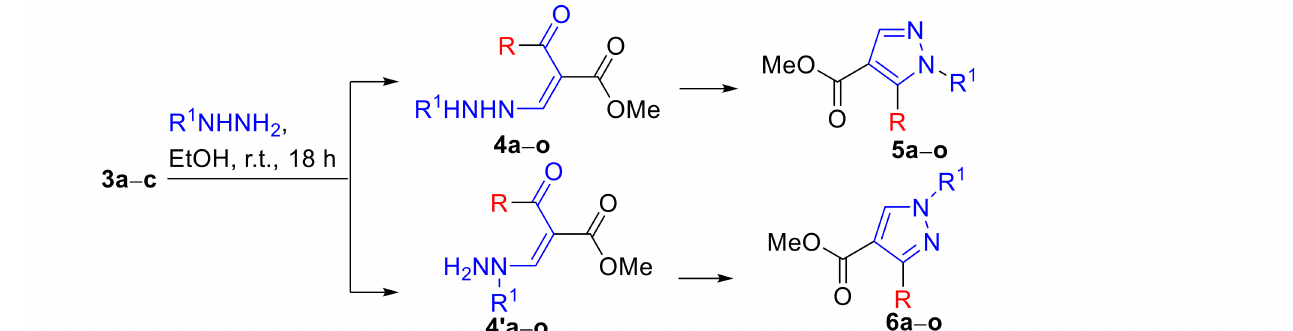
Scheme 1. Synthesis of starting β -enamino diketones 3a – c